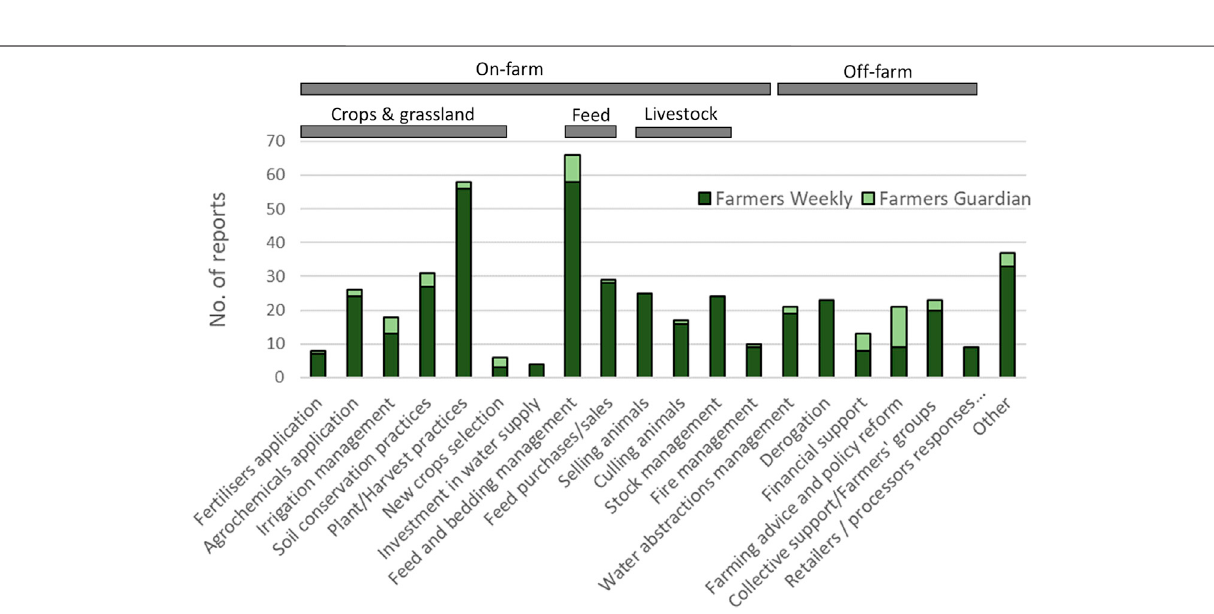
Table S2 ). These included actions to: